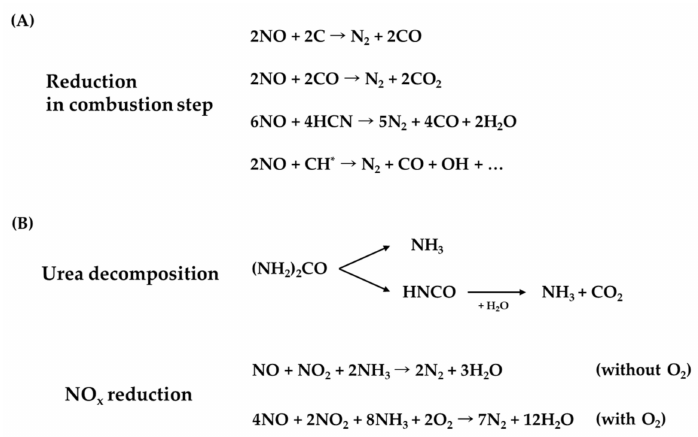
Figure 9. NO x reduction pathway (( A ) primary control, ( B ) post-control) with reducing